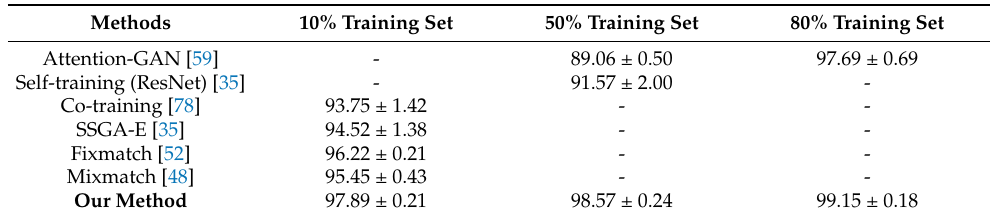
Table 3. Overall accuracy and standard deviations (%) of the proposed method and comparison methods on the UC Merced dataset.